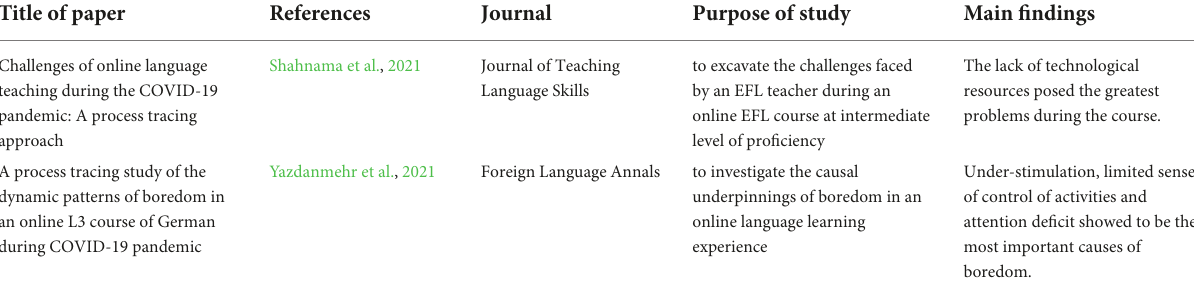
TABLE 1 A summary of the related literature on process tracing in language